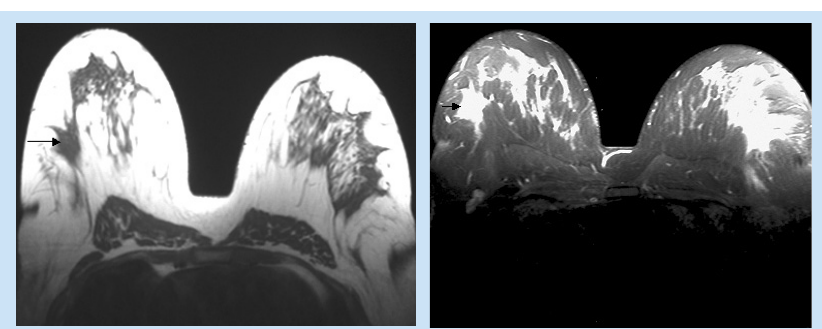
(arrow) on the magnified view,